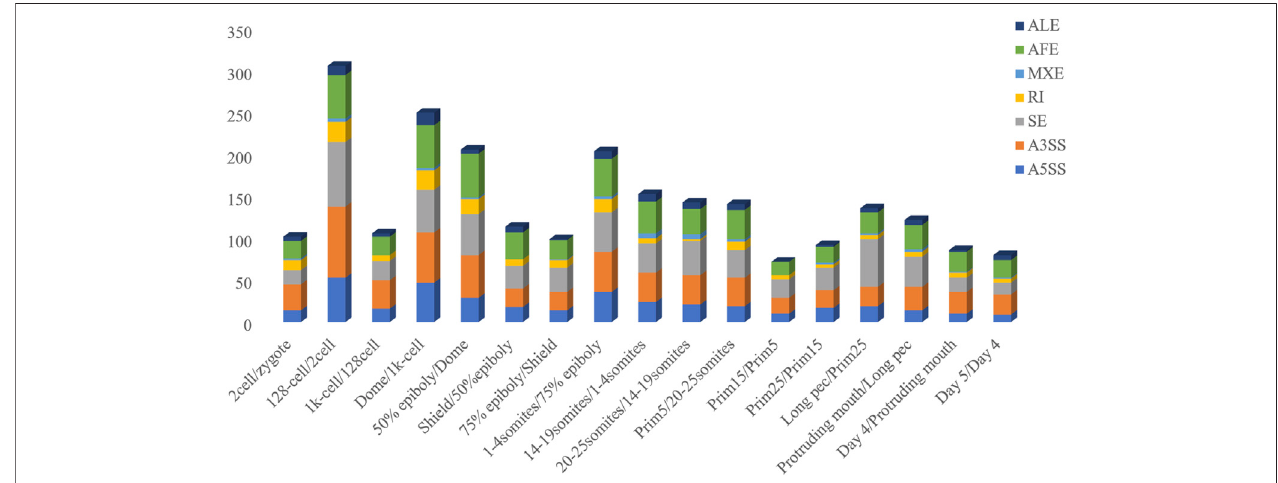
FIGURE 4 | Frequency of differential alternative splicing events between consecutive developmental stages.